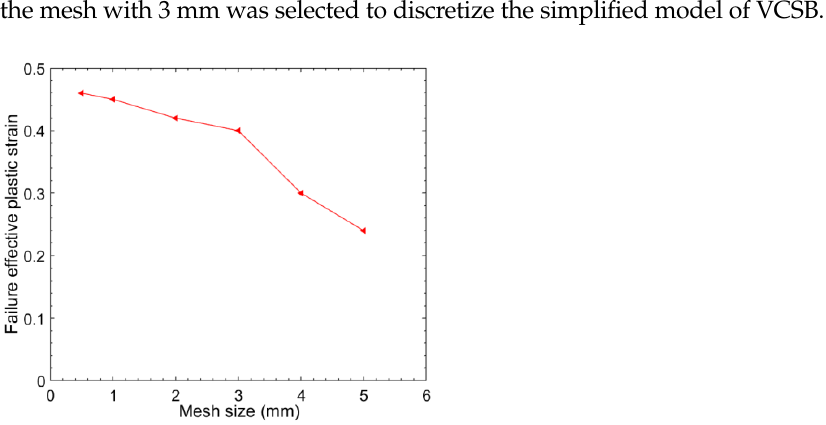
Figure 19. Failure attribute strain of finite element models of specimens with different mesh sizes. Table 5. Comparison of failure-effective plastic strain (F-EPS) of finite element models with different mesh sizes.